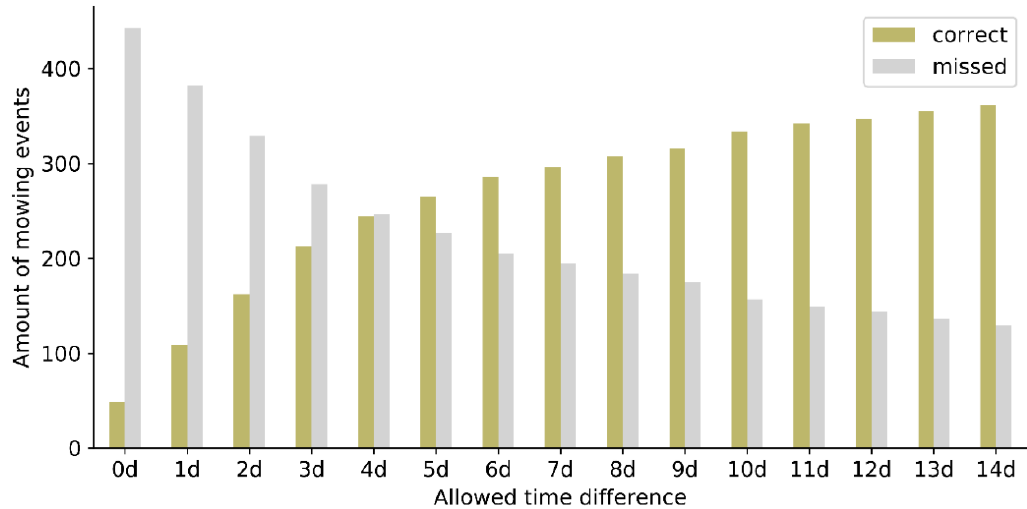
Figure 8. Number of correctly detected and missed mowing events depending on the allowed time difference between detection and actual mowing date. Table 3. Accuracy matrix of detected mowing events in Germany showing successfully detected, missed events, and false positives.